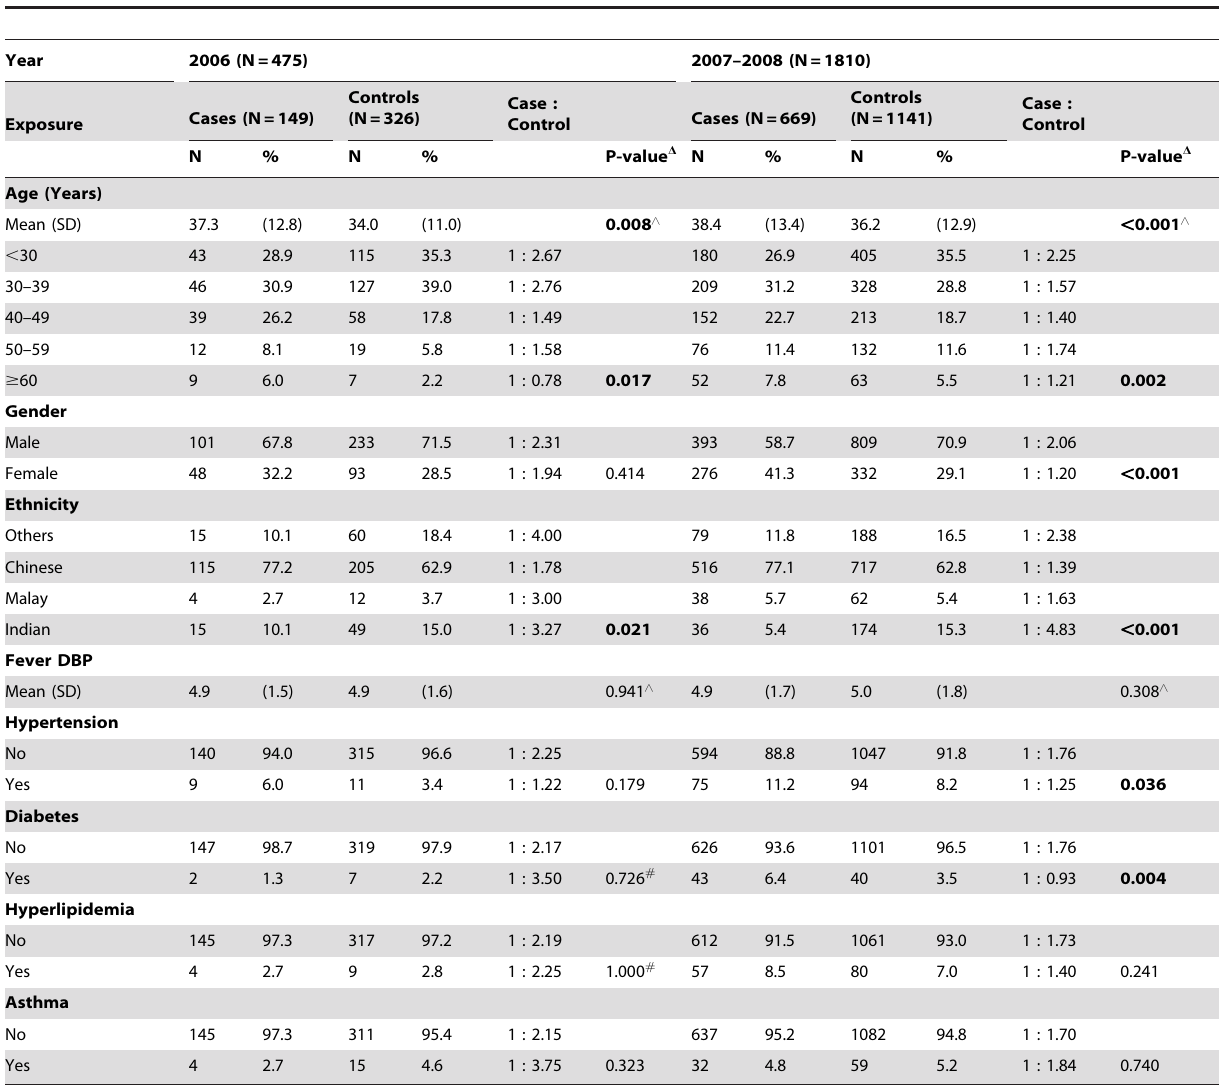
Table 1. Distribution of demographic characteristics and co-morbidities by cases (DHF) and controls (DF) in year 2006 and year 2007–2008